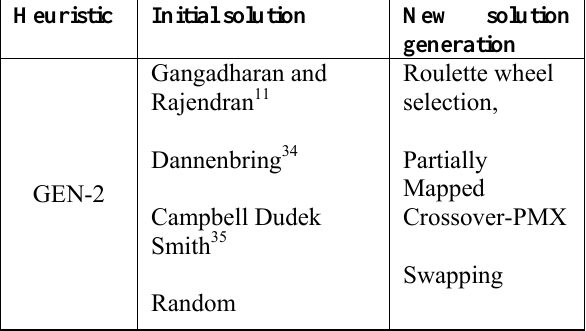
Table 2. Best GEN-2 heuristic method